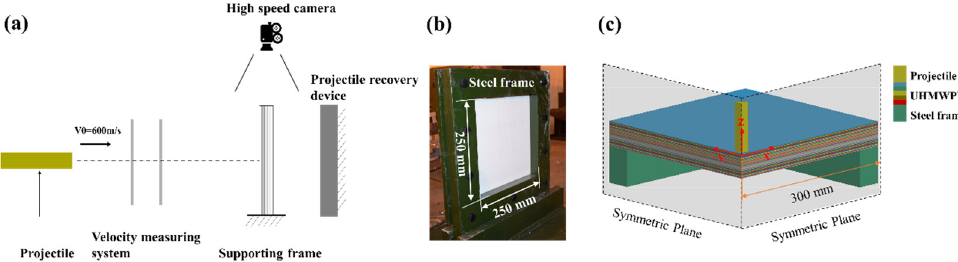
Figure 2. The tests process and the simulation model: ( a ) schematic diagram of the ballistic tests; ( b ) the steel frame for fixing the laminate; ( c ) the quarter-model for the impact configuration.